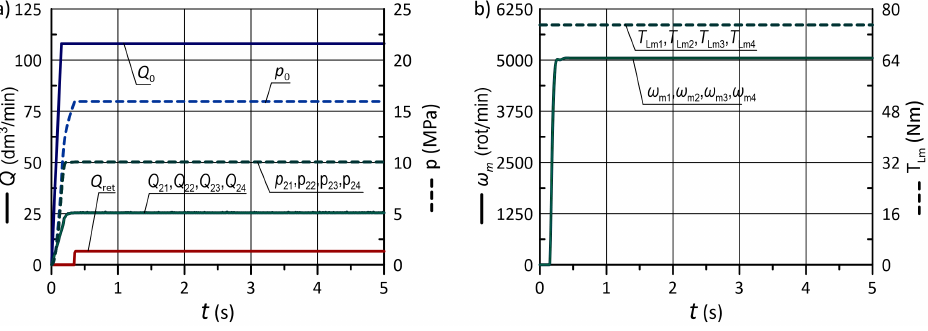
Figure 12. Results with constant load moment of high value T Lm = 75.0 N m: ( a ) flow rates and pressures; ( b ) rotational speed of hydraulic motors and load